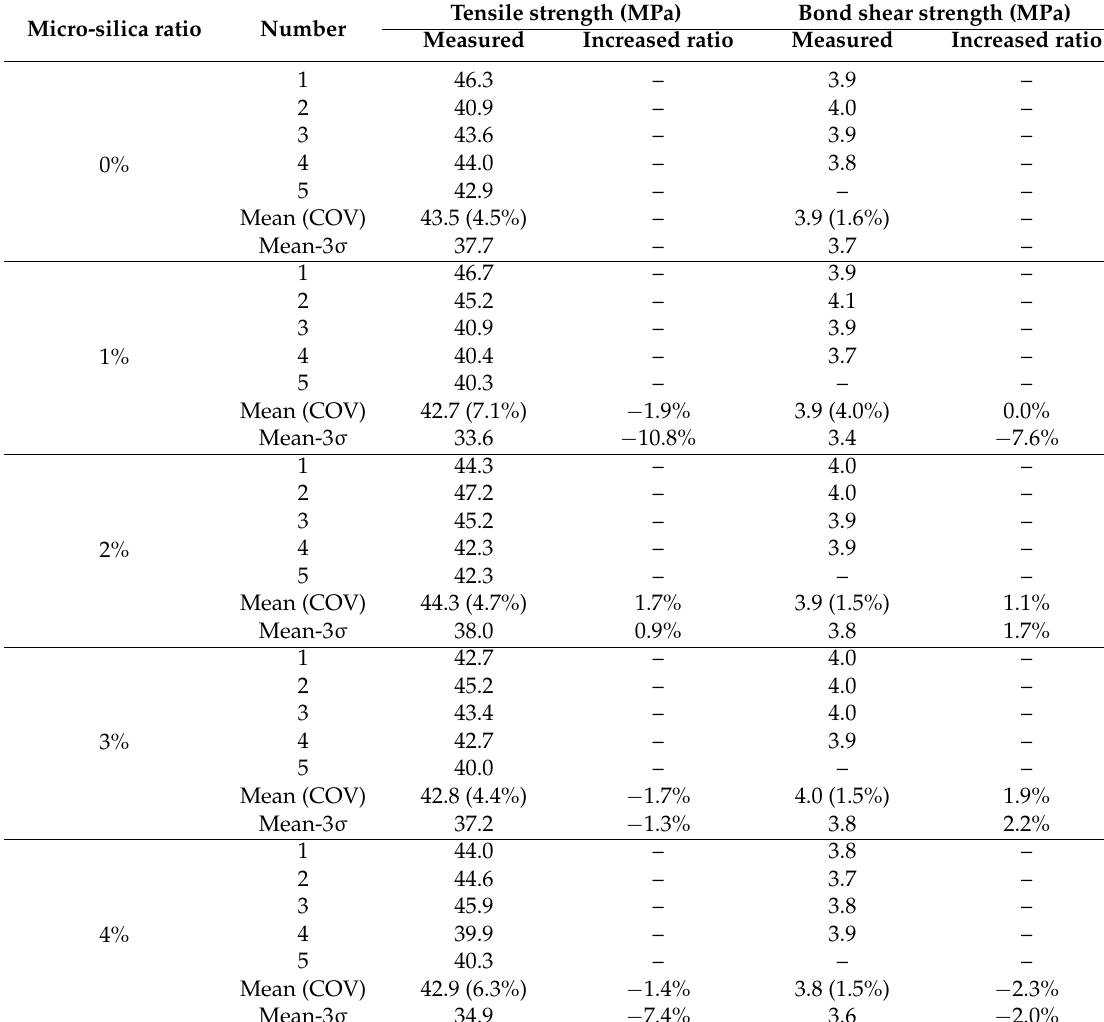
Table 4. Test results for MSAE as a function of the micro-silica mix ratio.